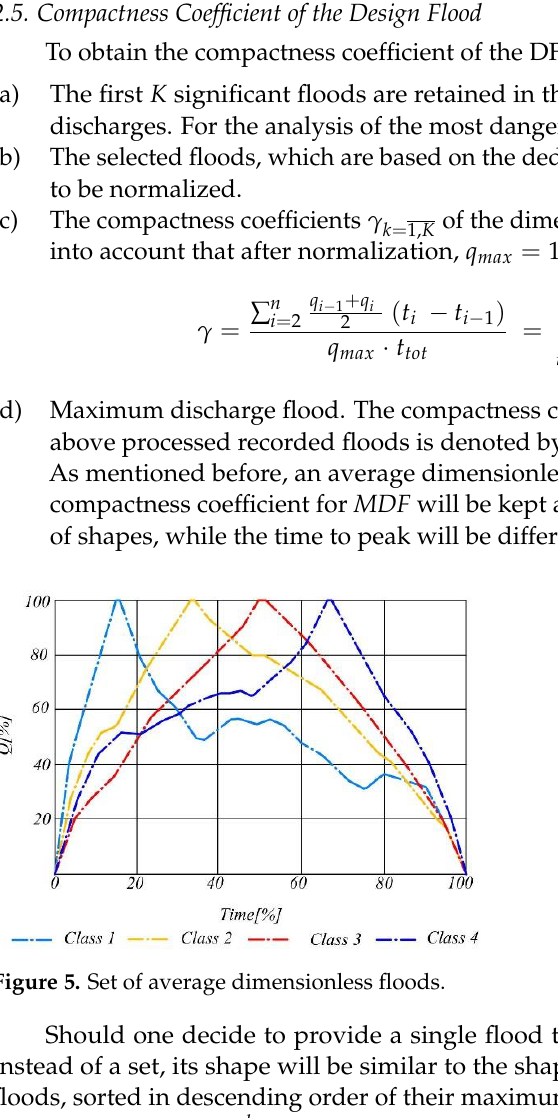
Figure 5. Set of average dimensionless floods.